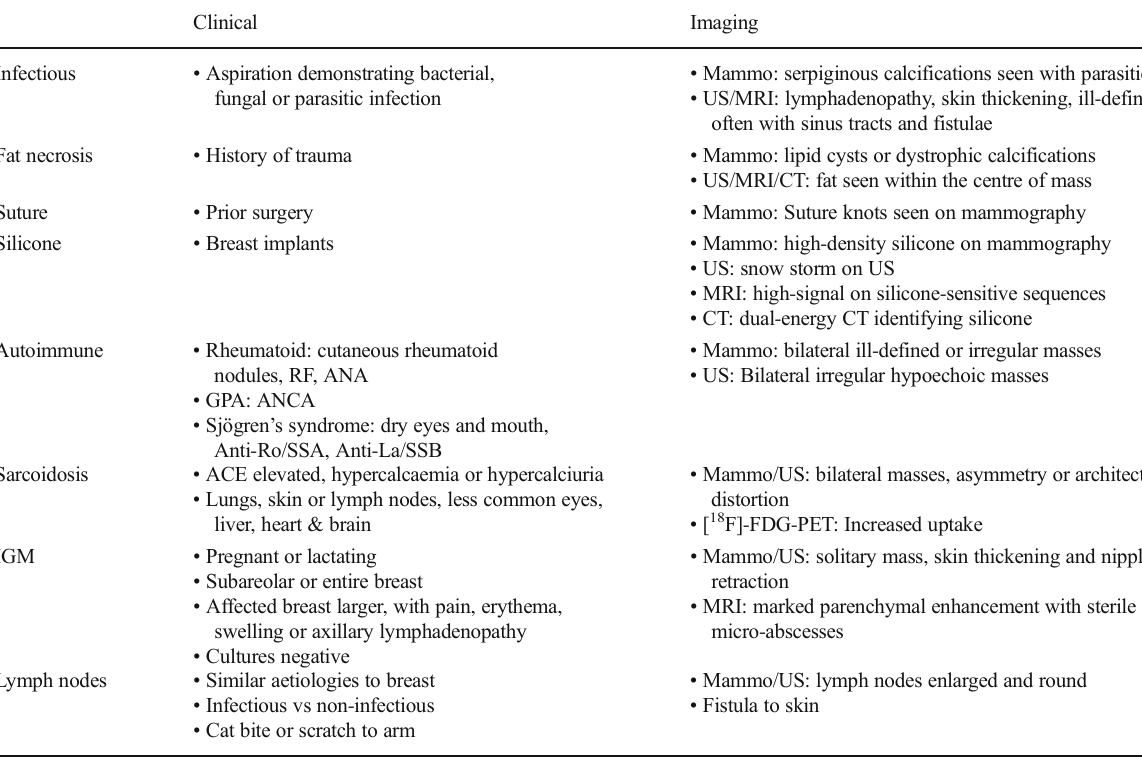
Table 1 Clinical and imaging findings of granulomatous processes of the breast and axilla Clinical Imaging